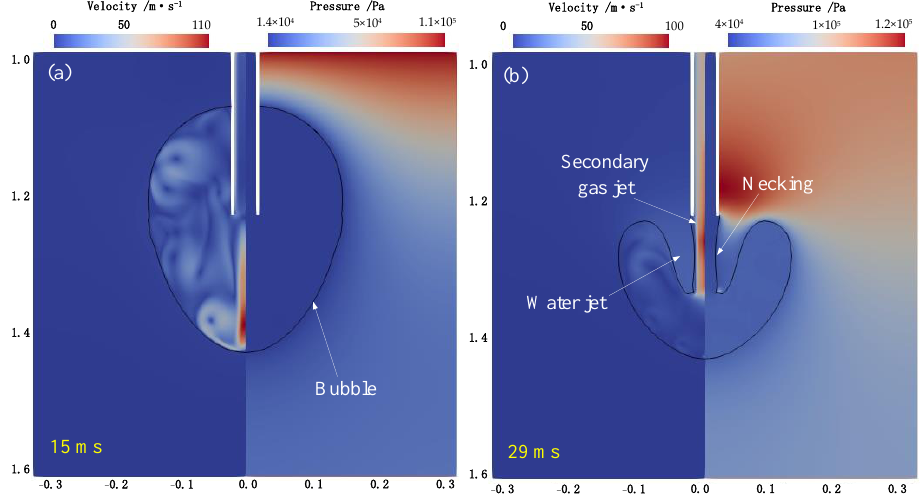
Figure 5. Simulation results of the bubble evolution process when the straight nozzle was installed: ( a ) t = 15 ms, ( b ) t = 29 ms.